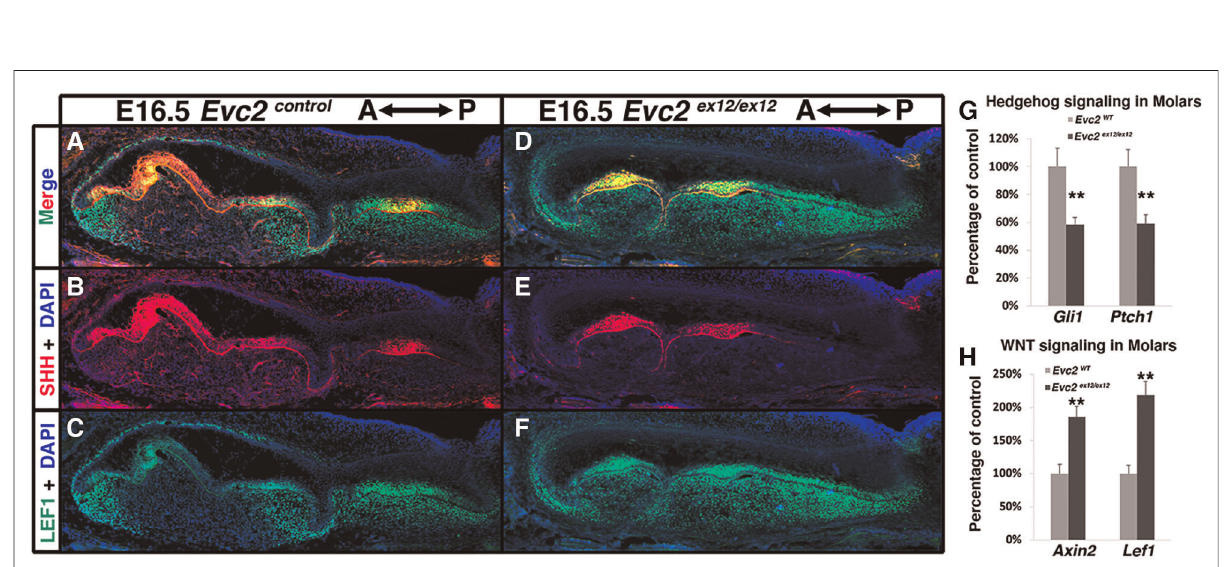
FIGURE 5 Evc2 mutation leads to decreased Hedgehog signaling and increased WNT signaling at E16.5 and later. Mandible molars of controls ( A – C ) and Evc2 mutants ( D – F ) were immunolabeled with LEF ( C,F ) for reading out WNT signaling and SHH ( B,E ). Hedgehog signaling ( G ) and WNT signaling ( H ) in molars were quanti fi ed through assessing the Gli1 , Ptch1 , Axin2 and Lef1 levels through q-RT-PCR. Percentage of controls were calculated and are shown in G and H. ( n =4; **, p <0.01).